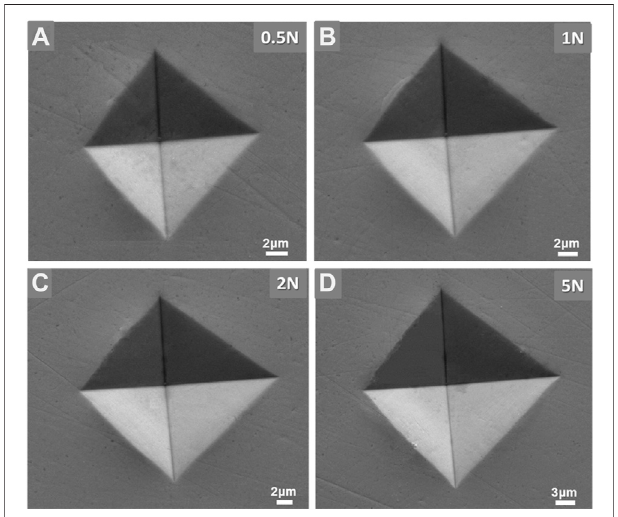
FIGURE 5 | Representative SEM images of Vickers indentation imprints of SR NGs at maximum indentation load, P max , of (A) 0.5 N, (B) 1 N, (C) 2 N, and (D) 5